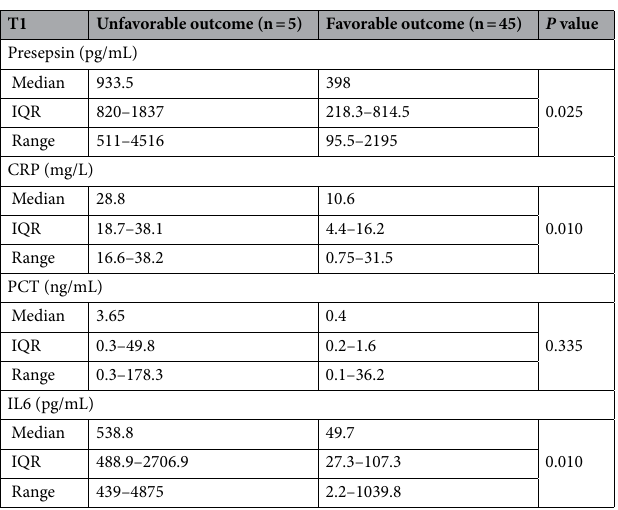
Table 3. Values of biomarkers according to the outcome of FN at T1. CRP: C reactive protein; IL6: interleukin 6; IQR: interquartile range; PCT: procalcitonin.